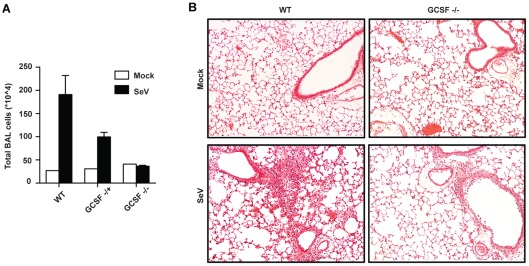
G-CSF deficiency reduces lung infiltrate during virus infection.(A) Total cell counts in cytospins made with bronchoalveolar lavage (BAL) 8 days after infection with SeV. (B) Representative pictures of H&E-stained lung sections from naive and SeV infected G-CSF+/+ and G-CSF−/− C57BL/6 mice.